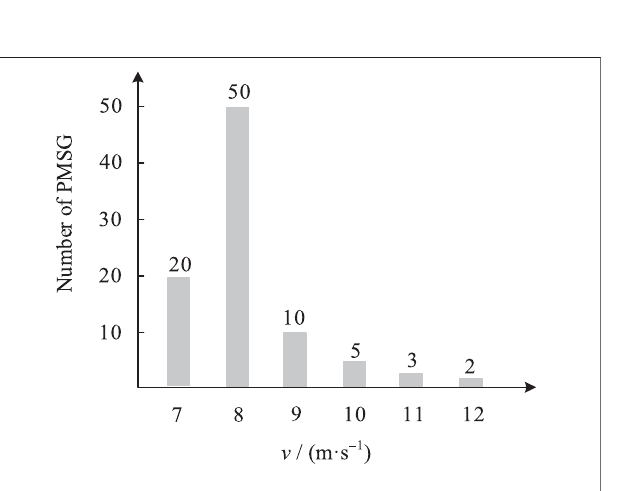
FIGURE 14 | Same distribution of D-PMSGs operating at different wind speeds in two wind farms.